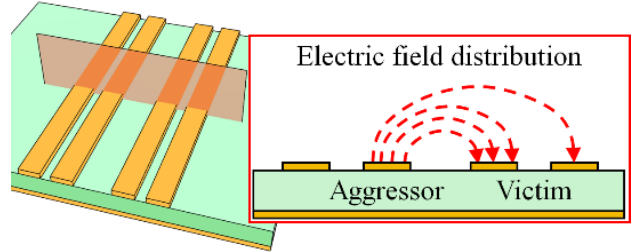
Figure 4. Crosstalk between the DL pairs, asymmetrically affecting each line of the DL.